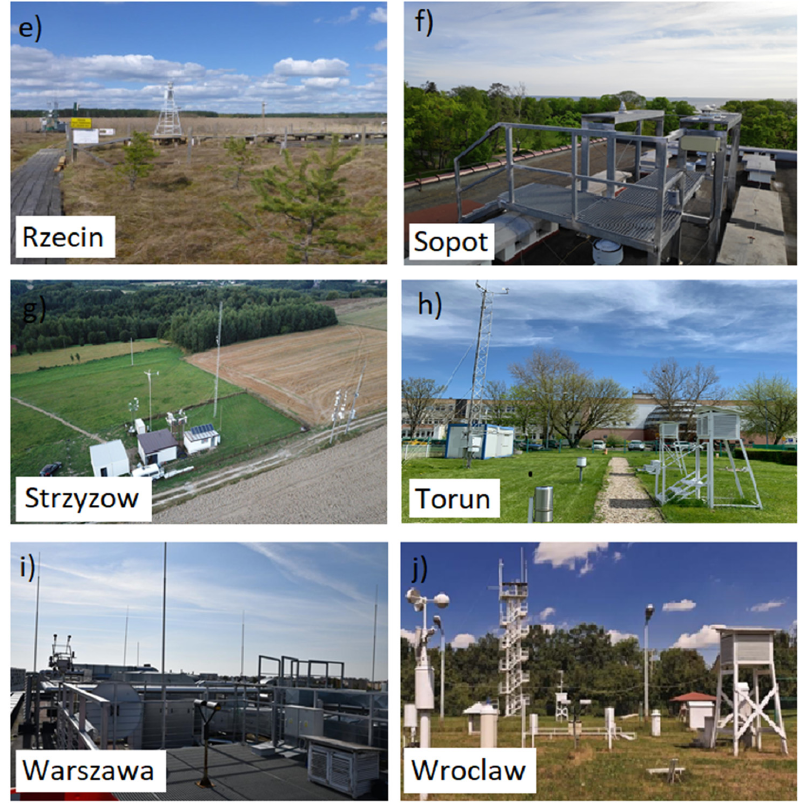
Figure 2. Poland-AOD research sites: ( a ) Belsk, ( b ) Borucino, ( c ) Debrzyna, ( d ) Raciborz, ( e ) Rzecin,